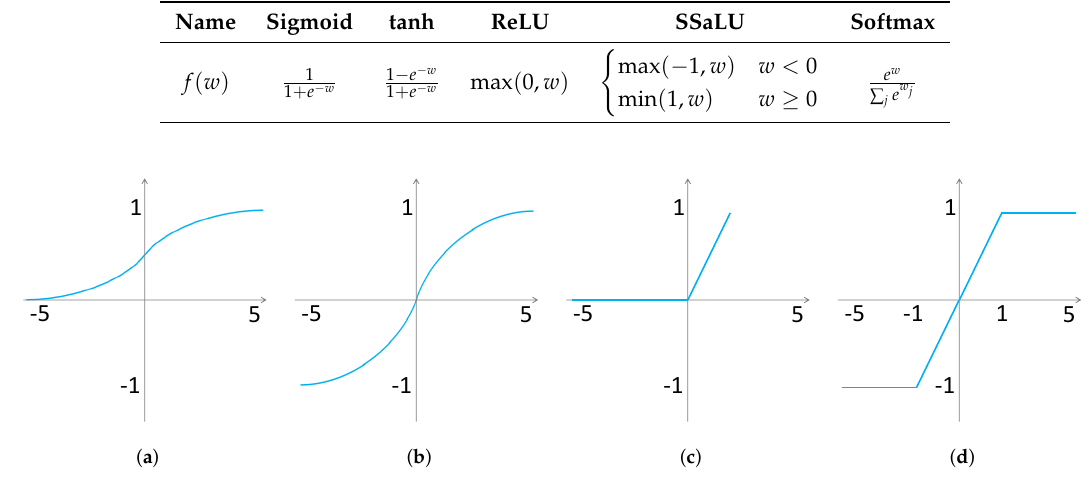
Table 1. Mathmatical expressions for activation functions.